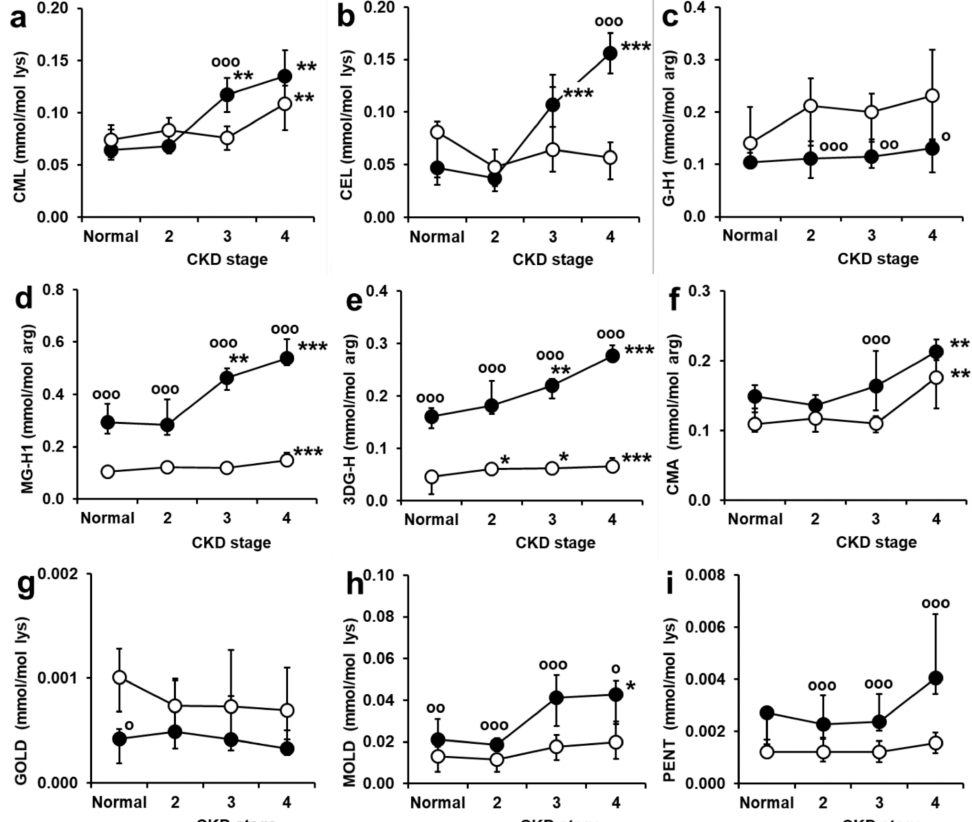
Figure 2. Serum protein-bound AGEs in subjects with normal renal function and stages 2–4 chronic kidney disease. ( a ) N ε -Carboxymethyl-lysine CML, ( b ) N ε -(1-Carboxyethyl)lysine CEL, ( c ) Glyoxal-derived hydroimidazolone G-H1, ( d ) Methylglyoxal-derived hydroimidazolone MG-H1, ( e ) 3-Deoxyglucosone-derived hydroimidazolone 3DG-H, ( f ) N ω -carboxymethylarginine CMA, ( g ) Glyoxal-derived lysine dimer GOLD, ( h ) Methylglyoxal-derived lysine dimer MOLD,